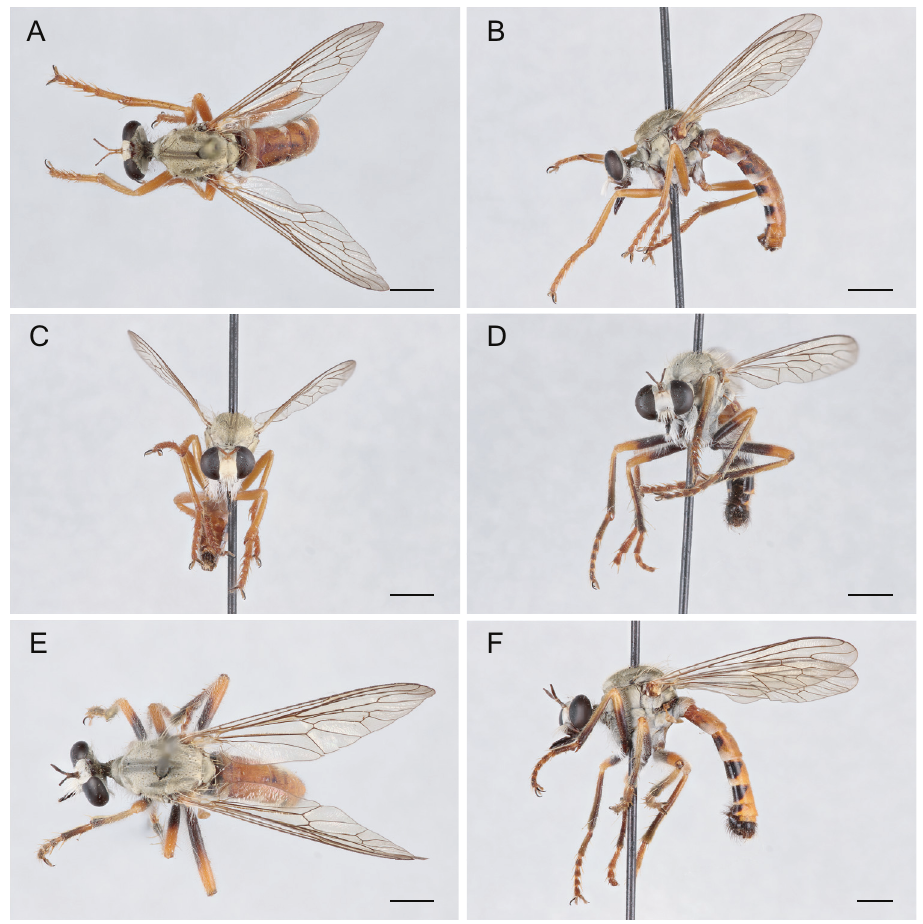
Figure 11. Saropogon coquillettii Back 1909 Female (USNMENT01830076): A dorsal view B lateral view C anterior view; Male (USNMENT01830075): D anterior view E dorsal view F lateral view. Scale bars: 2